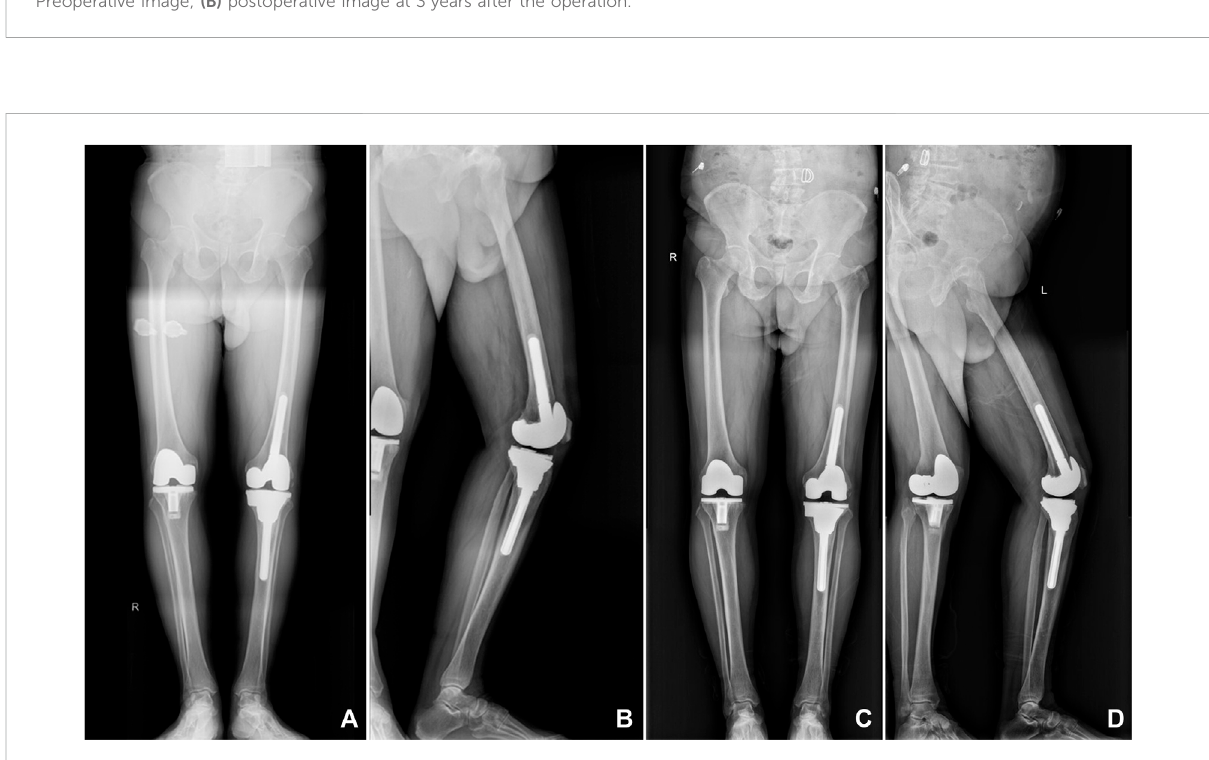
FIGURE 7 X-rayimagesofarepresentativepatient showedthatthe3D-printedporoustantalumconeisstableandtightlyintegratedwith thesurrounding bone tissue. (A,B) Postoperative radiographs were taken at 6 months after surgery; (C,D) postoperative radiographs were taken at 3 years after